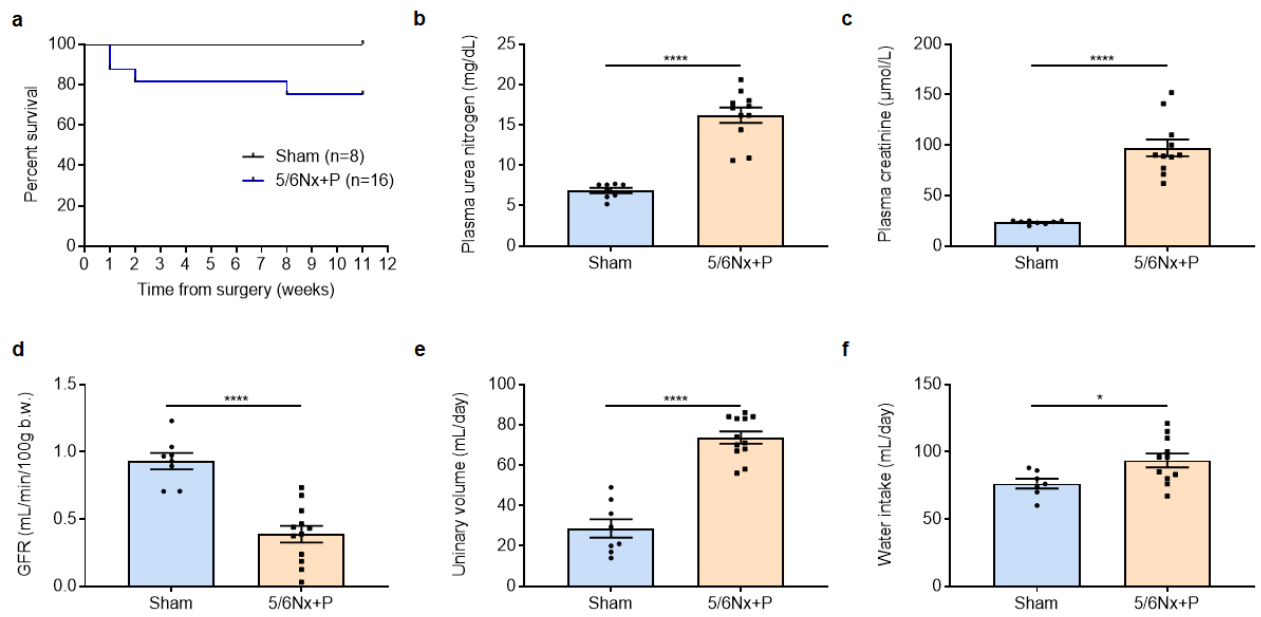
Figure 1. Eleven-week survival after surgery ( a ), plasma creatinemia ( b ), urea nitrogen ( c ), glomerular filtration rate (GFR, d ), urinary volume ( e ), and water intake ( f ) measured 10 to 11 weeks after surgery in sham-operated and 5/6 nephrectomized rats receiving a high-phosphate diet (5/6Nx + P). * p < 0.05, **** p <